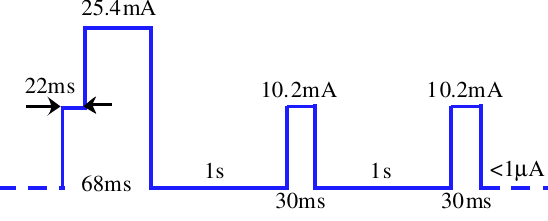
Figure 7. LoRa board current consumption profile in one Rx / Tx cycle. Table 1. Average LoRa board power